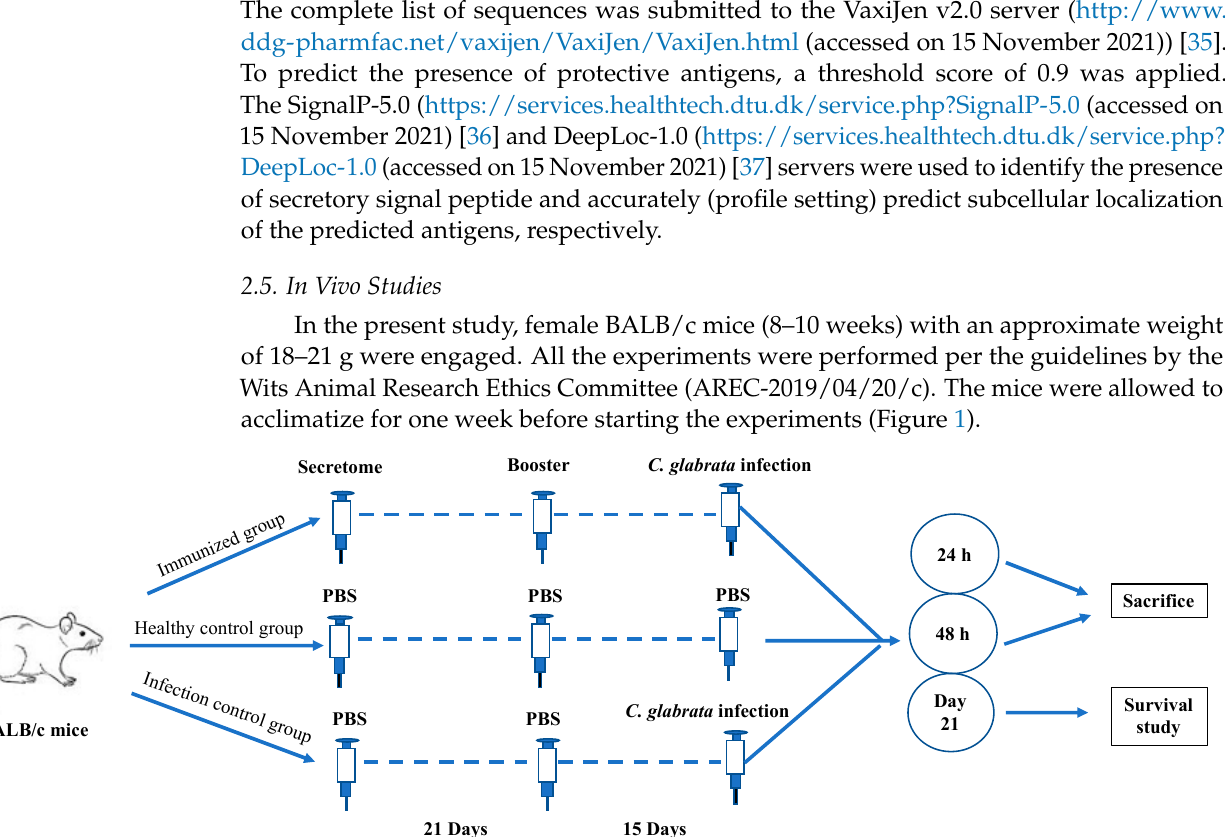
Table 1. Antifungal susceptibility profile of C. glabrata strains .